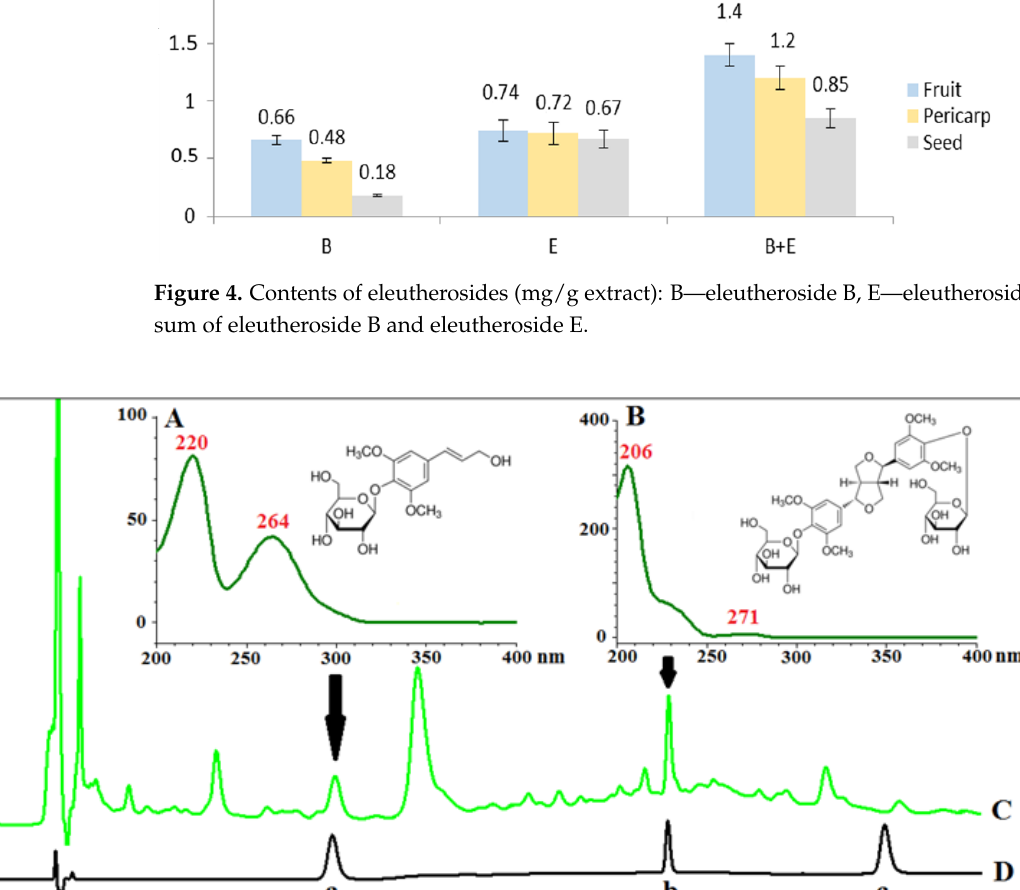
Figure 5. Chromatogram of Eleutherococcus senticosus fruit and reference standards with PDA spectra and structures of determined compounds: ( A )—PDA spectrum and chemical structure of eleutheroside B; ( B )—PDA spectrum and chemi- cal structure of eleutheroside E; ( C )—chromatogram of the extract of Eleutherococcus senticosus fruit; ( D )—chromatogram of the mixture of standards ( a —eleutheroside B, b —eleutheroside E, c —eleutheroside E1). RP18e LiChrospher 100 col- umn (Merck, Darmstadt, Germany) (25 cm × 4.0 mm i.d., 5 µm particle size) at 25 °C; mixtures of water (solvent A) ace- tonitrile (solvent B) and both acidified with 0.025% of trifluoroacetic acid were used as the mobile phase. The com- pounds were separated by gradient elution with the following program: 0.0–8.0 min A 90%, B 10%; 8.1–18.0 min A 90– 80%; B 10–20%, 18.1–30.0 min A 80%, B 20%. The flow rate was 1.0 mL/min.